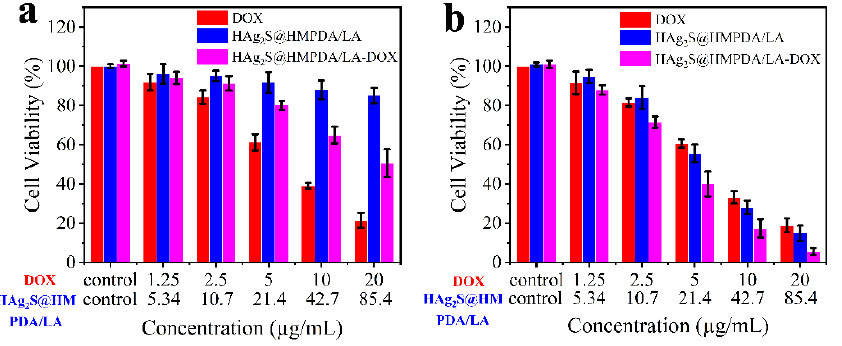
Figure 10. Relative viabilities of HepG2 cells incubated with DOX, HAg 2 S@HMPDA/LA, and HAg 2 S@HMPDA/LA-DOX without laser ( a ) and with laser ( b ).